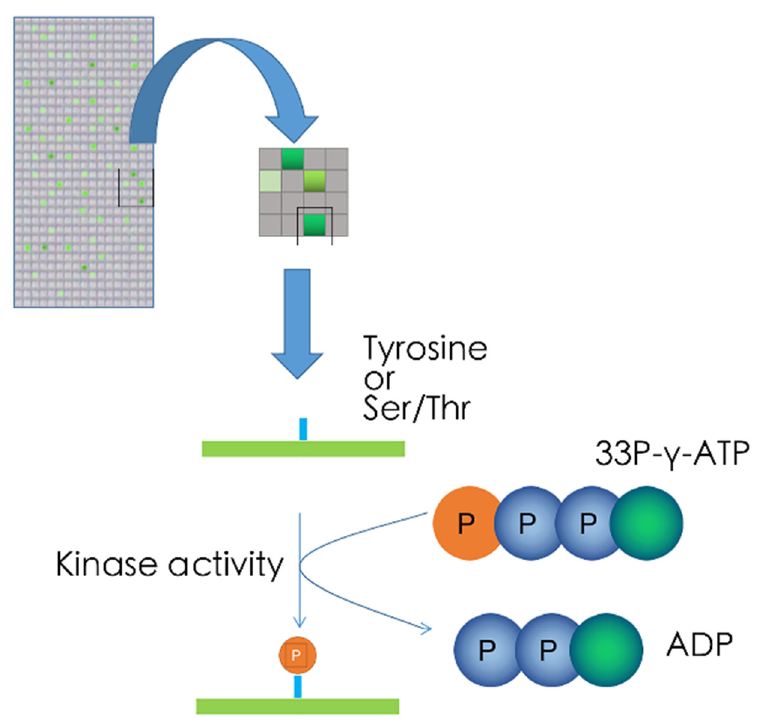
Figure 4. Peptide array-based profiling. Spatially addressed peptide substrates are immobilized and incubated with biological samples. Kinase activity is detected by incorporation of radioactivity into the substrates.